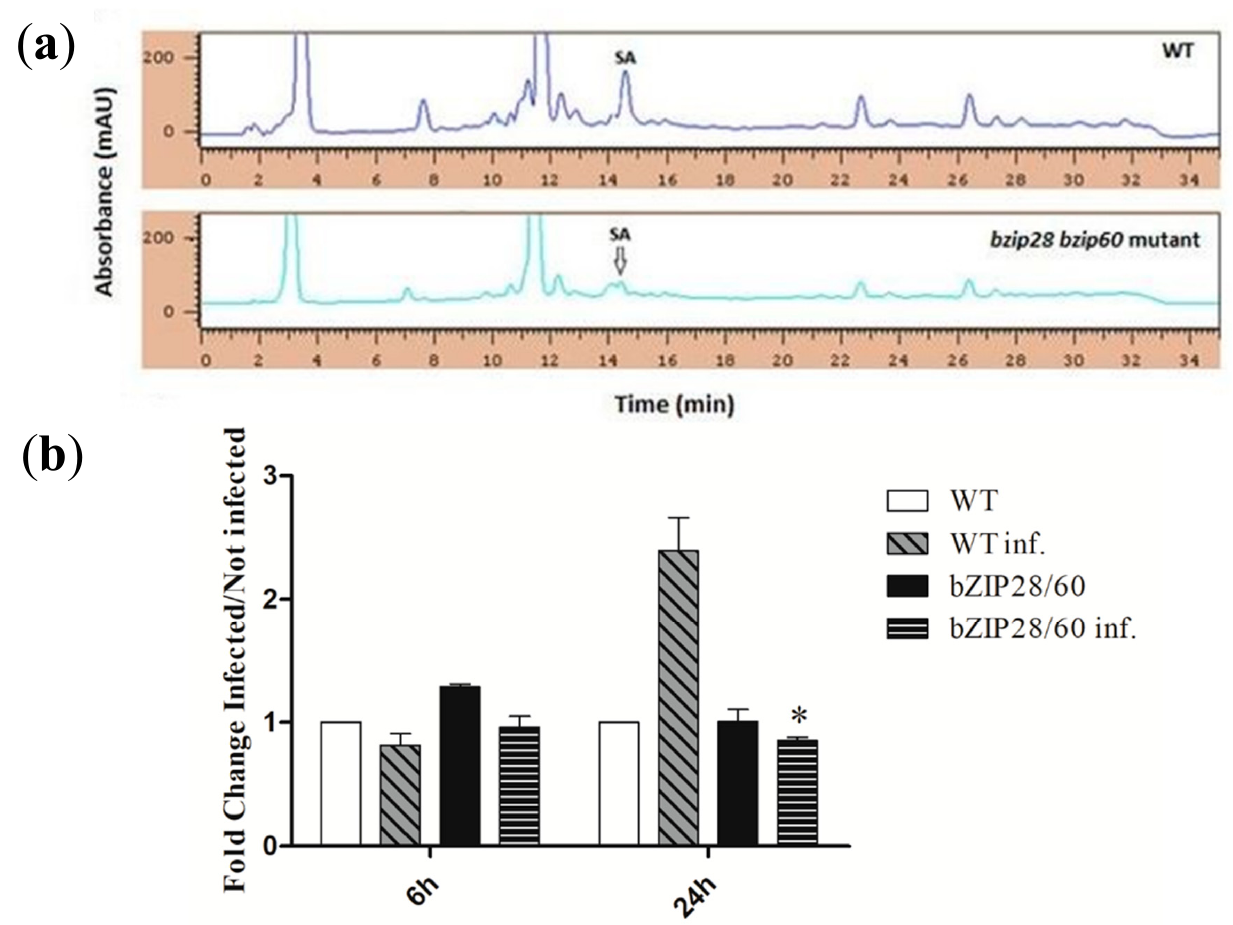
Figure 6. HPLC determination of SA content ( a ) and qRT-PCR analysis of ICS1 gene transcription ( b ) in leaves from WT and bzip28 bzip60 mutant Arabidopsis plants infected by D. gigantea for 24 h. ( a ) Exemplificative chromatographic profile of a sample of extract from leaves of WT (Top) and bzip28 bzip60 mutant (Bottom) Arabidopsis plants infected by D. gigantea for 24 h. ( b ) mRNA levels were quantified by qRT-PCR, using ACT8 as housekeeping gene. The results of the infected plants are reported as fold changes with respect to non-infected WT (6 h) considered as unit. The results represent the mean values ± SD of independent experiments ( n = 3). Samples were run in technical triplicates. Statistical significance was attributed by Student’s test (* p <